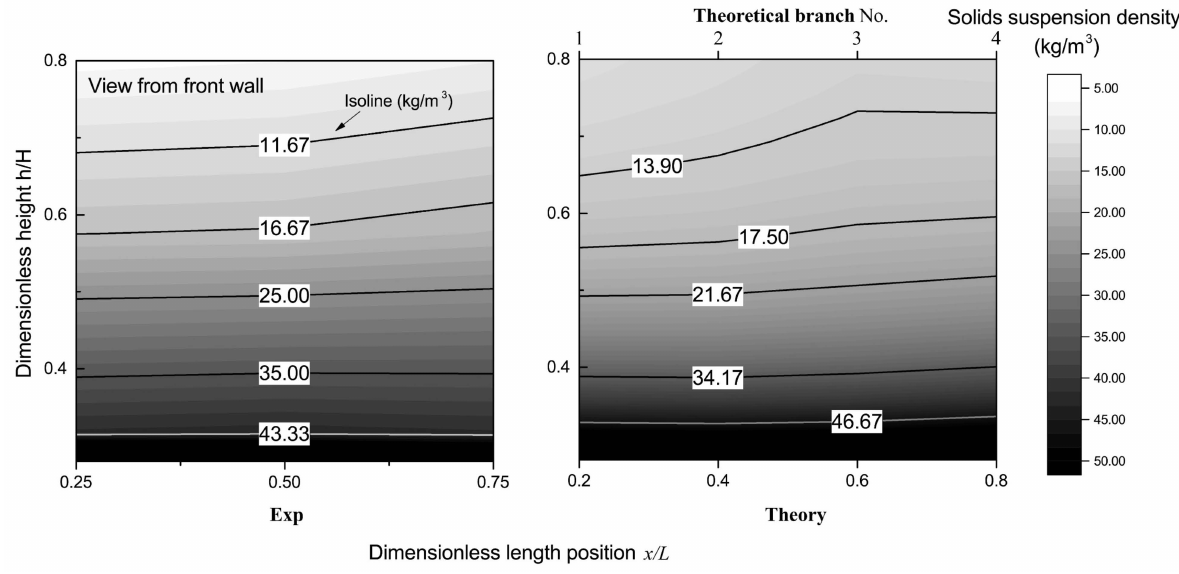
Figure 10. The contour of furnace suspension density of C-type